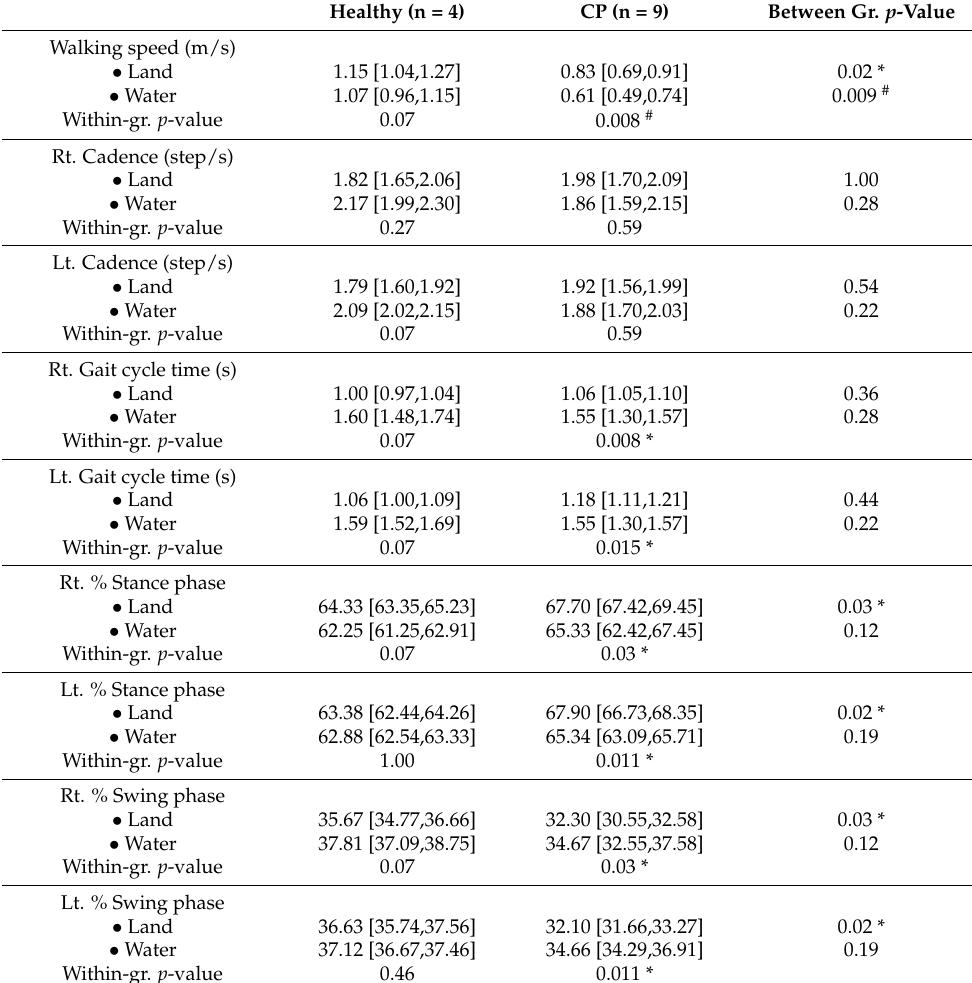
BMI; body mass index, GMFCs; gross motor function classification system. Table 2. Spatiotemporal parameters of a gait cycle in CP and healthy